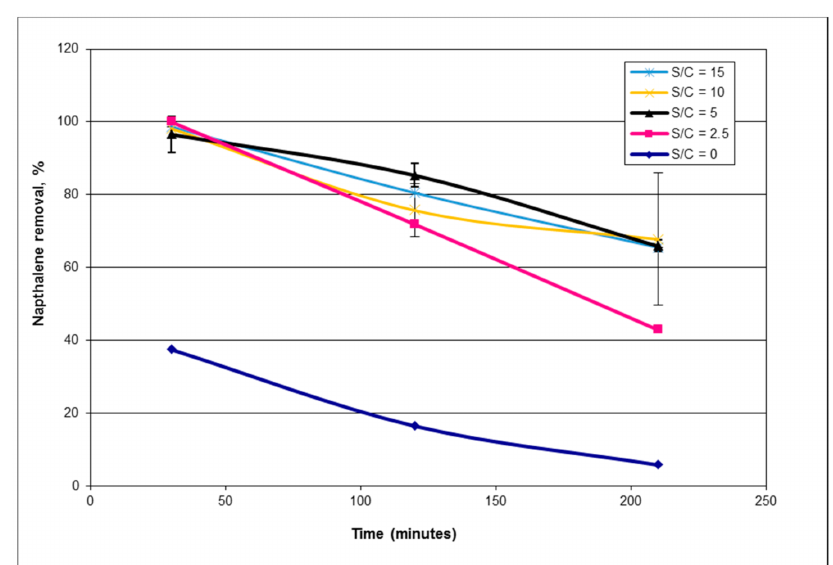
Figure 5. Effect of the S/C ratio on naphthalene removal efficiency (T—750 ◦ C, GHSV—12,800 h − 1